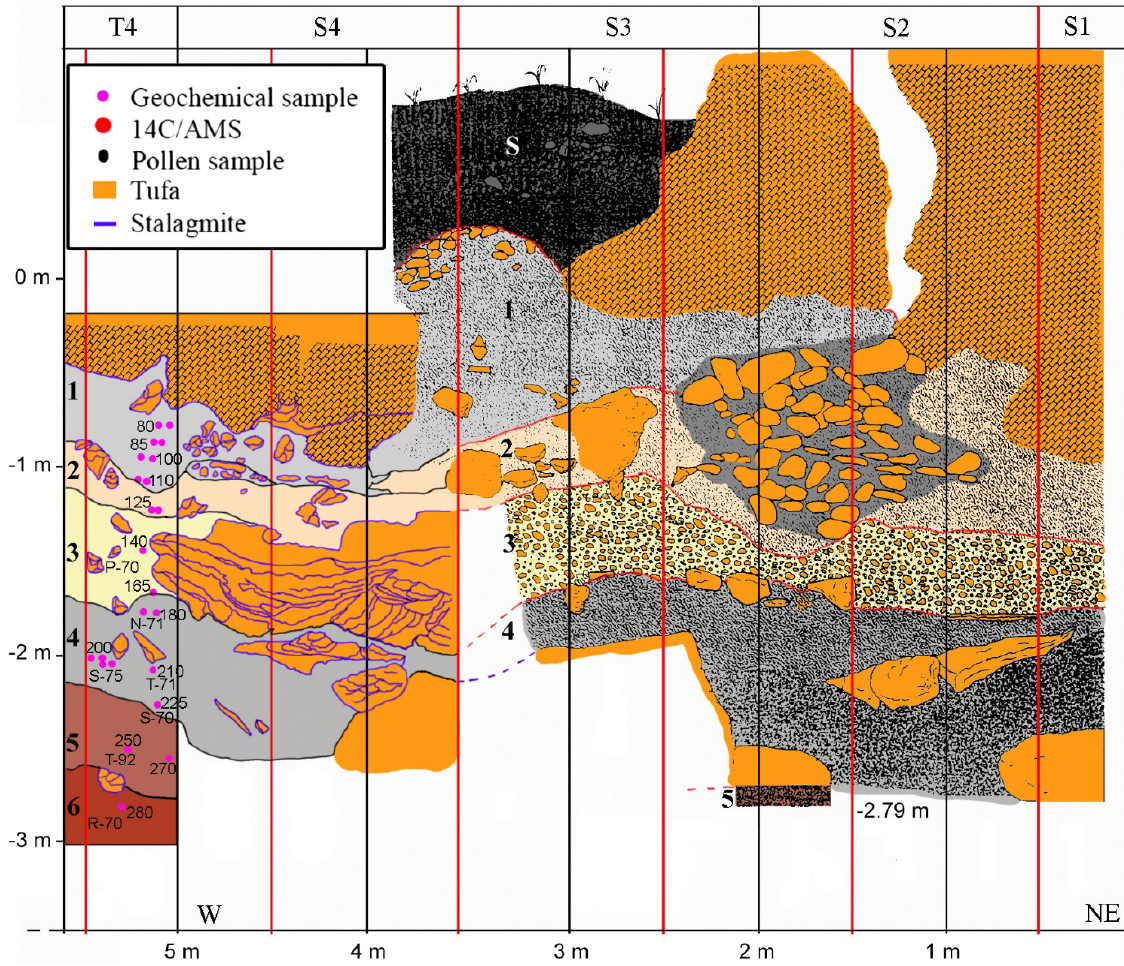
Figure 2. Stratigraphic column of El Pirulejo site (Cortés 2001). On the other hand the stratigraphical series fits within the Late Upper